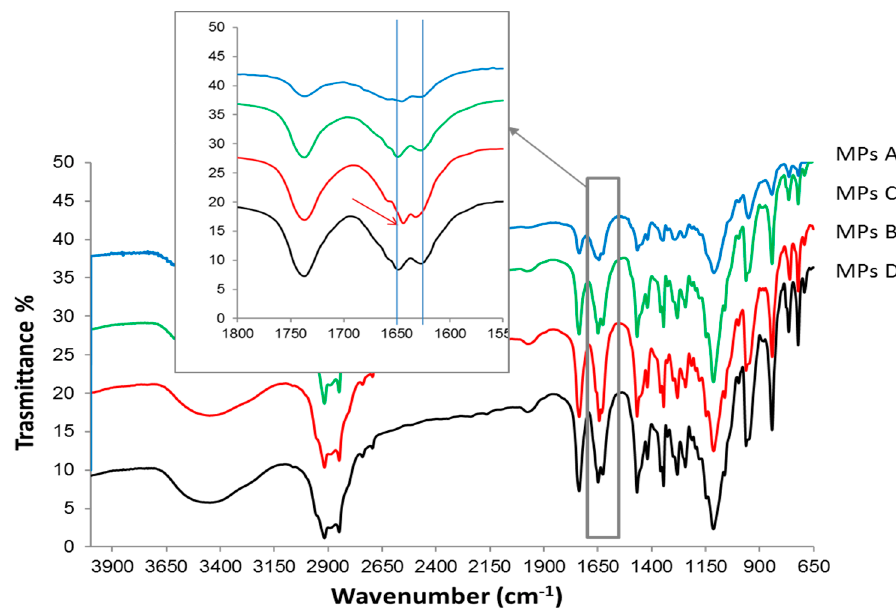
Figure 10. FT-IR spectra of the microparticle formulations.